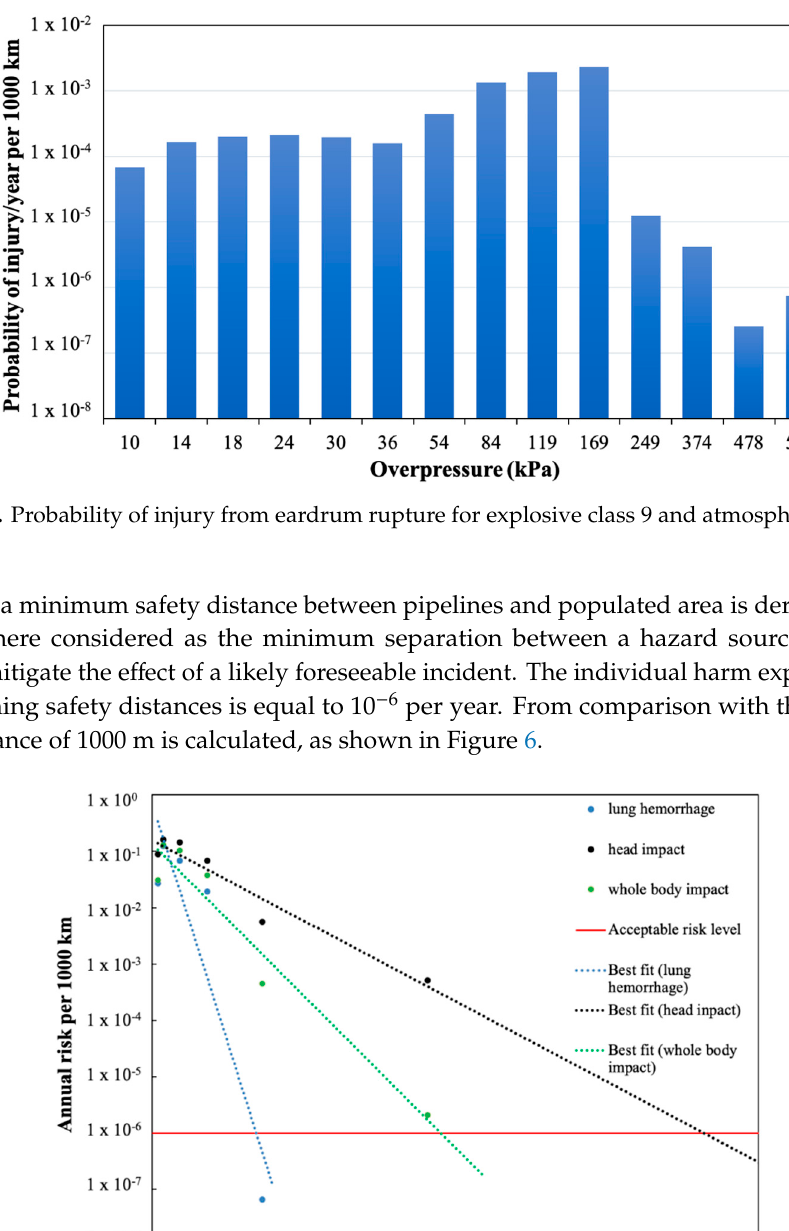
Figure 5. Probability of injury from eardrum rupture for explosive class 9 and atmospheric stability class F2.